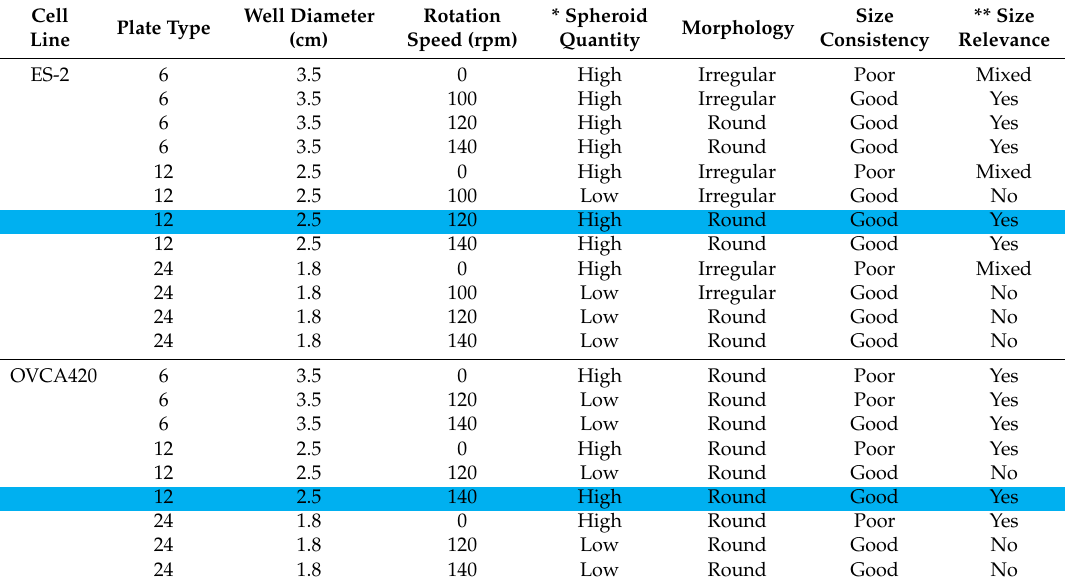
Table 1. Summary of well size/rotation speed